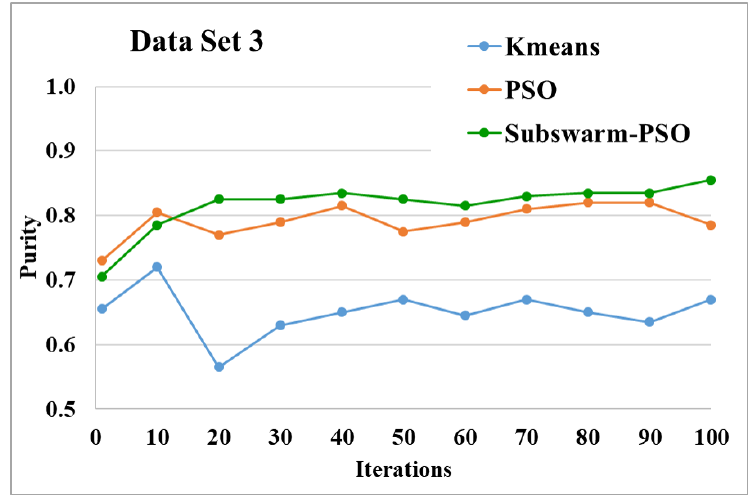
Figure 9. Purity comparison for data set